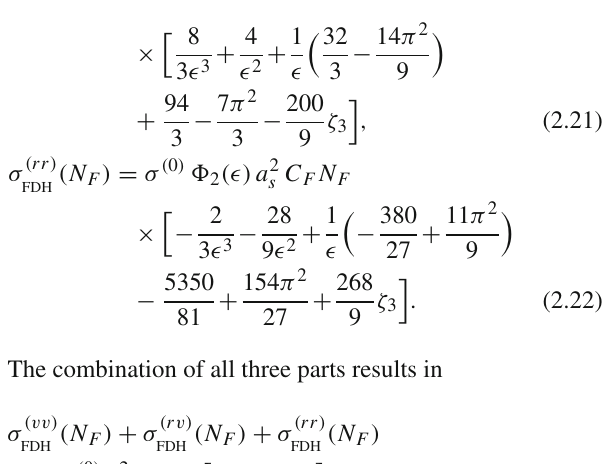
Fig. 2 The one-loop correction to the bottom